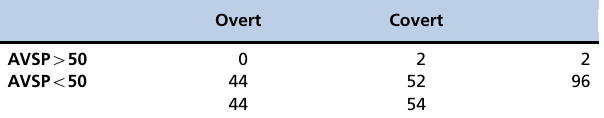
Table 4 - Hyperfunction (AVSP 4 50 degrees) and the presence of overt and covert saccades.